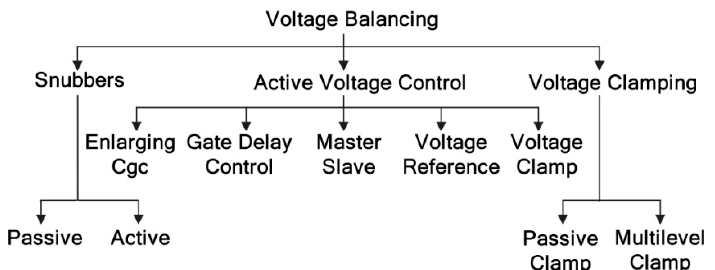
Figure 1. Summary of the technique types for voltage sharing of series-connected IGBTs.